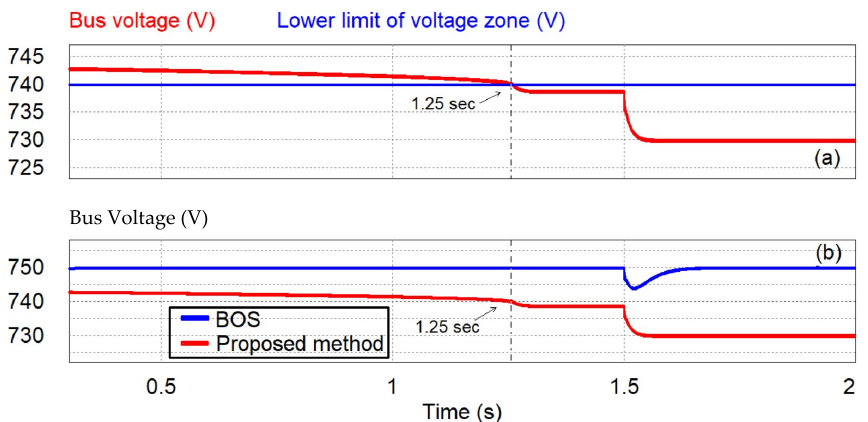
Figure 18. ( a ) The DC bus voltage and the lower voltage limit in the proposed method; ( b ) the DC bus voltage in both methods—Case 3.